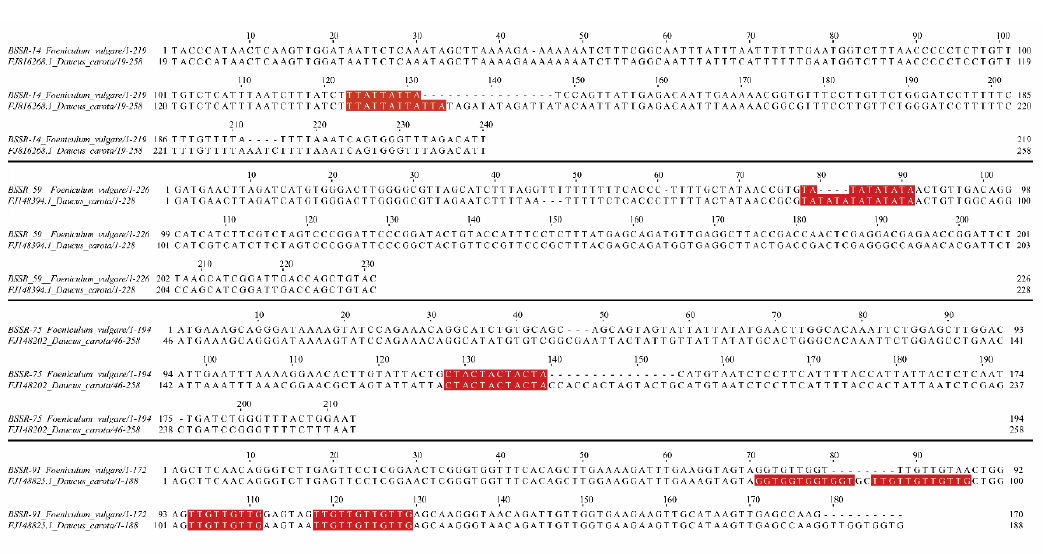
Table 1. SSR motifs comparison between Daucus carota from Cavagnaro et al. [43] and Foeniculum vulgare . Locus Accession No.